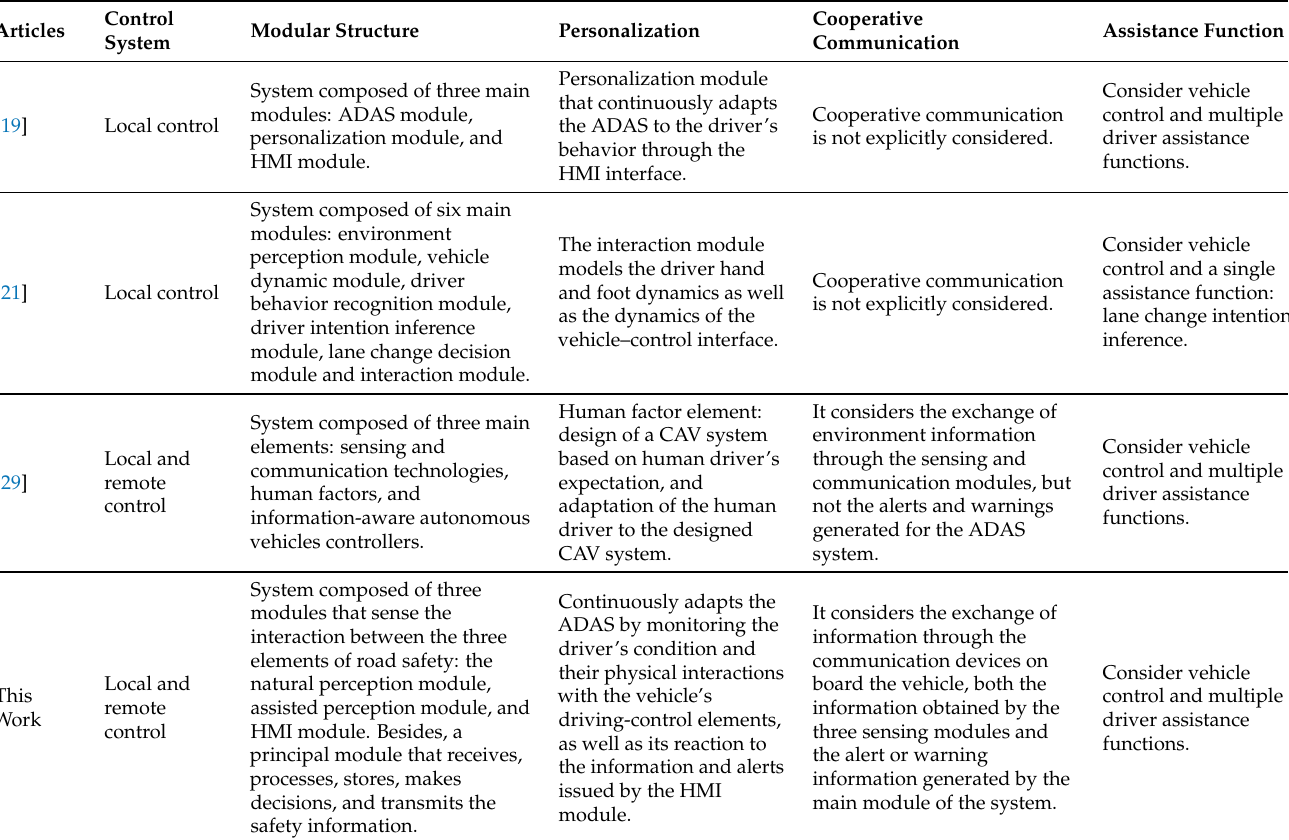
Table 2. Analysis of the ADAS architecture proposed in the revised surveys and the architecture proposed in this